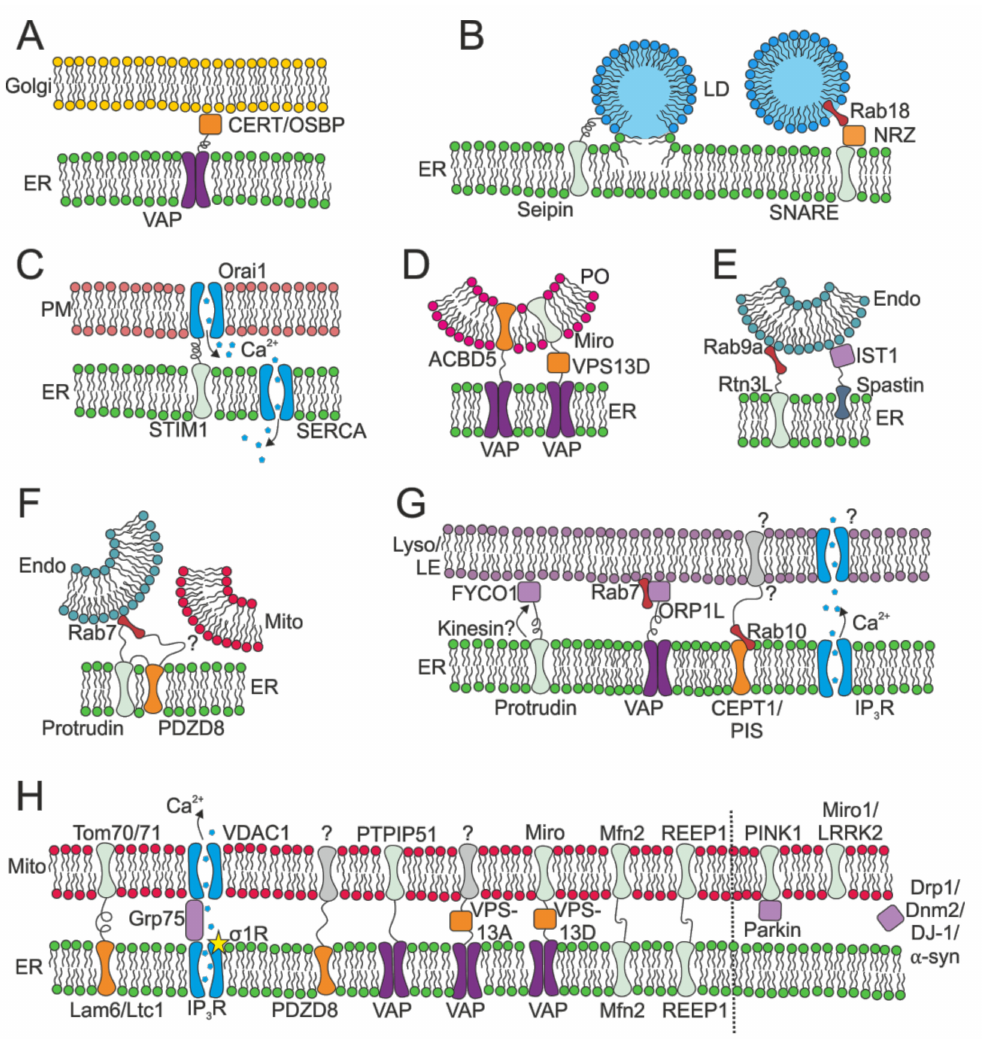
Figure 2. Membrane contact site proteins that are discussed in this review. MCSs between the ER and the Golgi apparatus ( A ), lipid droplets (LD, ( B )), the plasma membrane (PM, ( C )), peroxisomes (PO, ( D )), early endosomes (Endo, ( E )), late endosomes/lysosomes (LE/Lyso, ( G )) and mitochondria (Mito, ( H )) are shown. The triple MCS between the ER, endosomes, and mitochondria is also depicted ( F ). Orange proteins are those known, or thought to be, involved in lipid transfer and blue proteins are calcium ion channels. Proteins with no clear function in relation to lipid or calcium ion transfer are coloured light green (transmembrane) or lilac. The dotted line in H separates MCS-forming proteins (on the left of the line) from proteins recruited to MCSs and those whose interacting partners are unknown or not included in this review. The ER–mitochondrial MCS-forming mechanisms of mitofusin 2 and REEP1 are still unclear, however, both proteins may form homodimers in order to tether the organelles